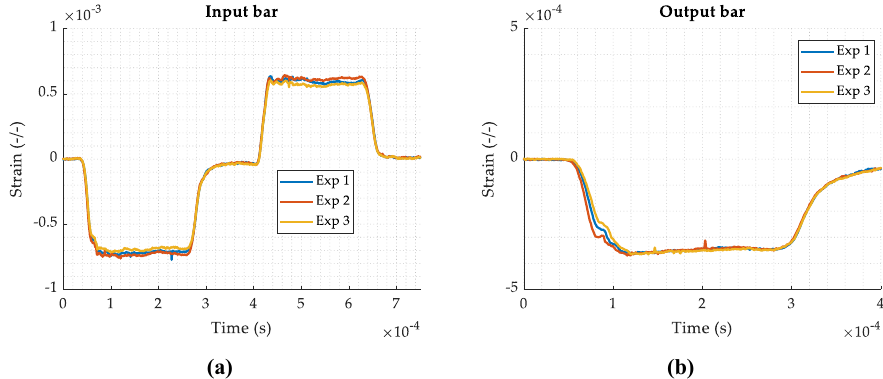
Fig 2. Comparison of the strain signals for the 3 tests at v 1 = 11 m/s and 293 K measured on: (a) the input bar; (b) the output